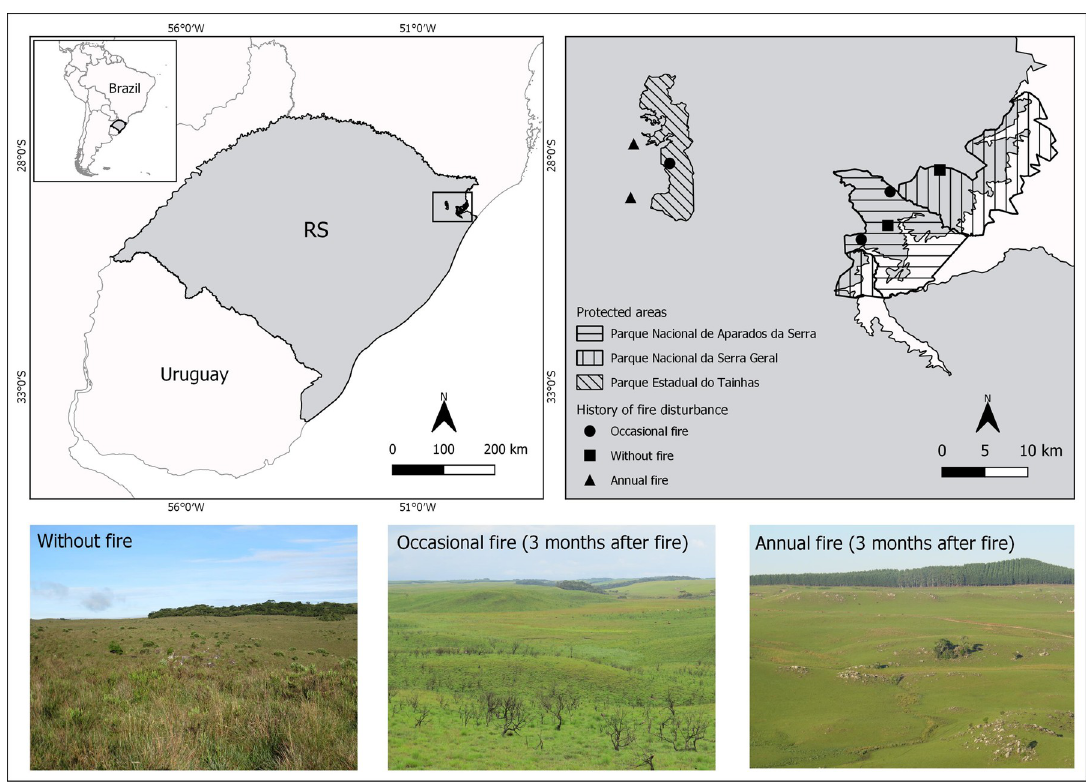
Fig 1. Locations of the study areas in highland grasslands in northeastern Rio Grande do Sul (RS) state, Brazil. Pictures are examples of landscapes of the three histories of fire disturbance in our study areas. Map created using QGIS software, version 3.6. Photos by